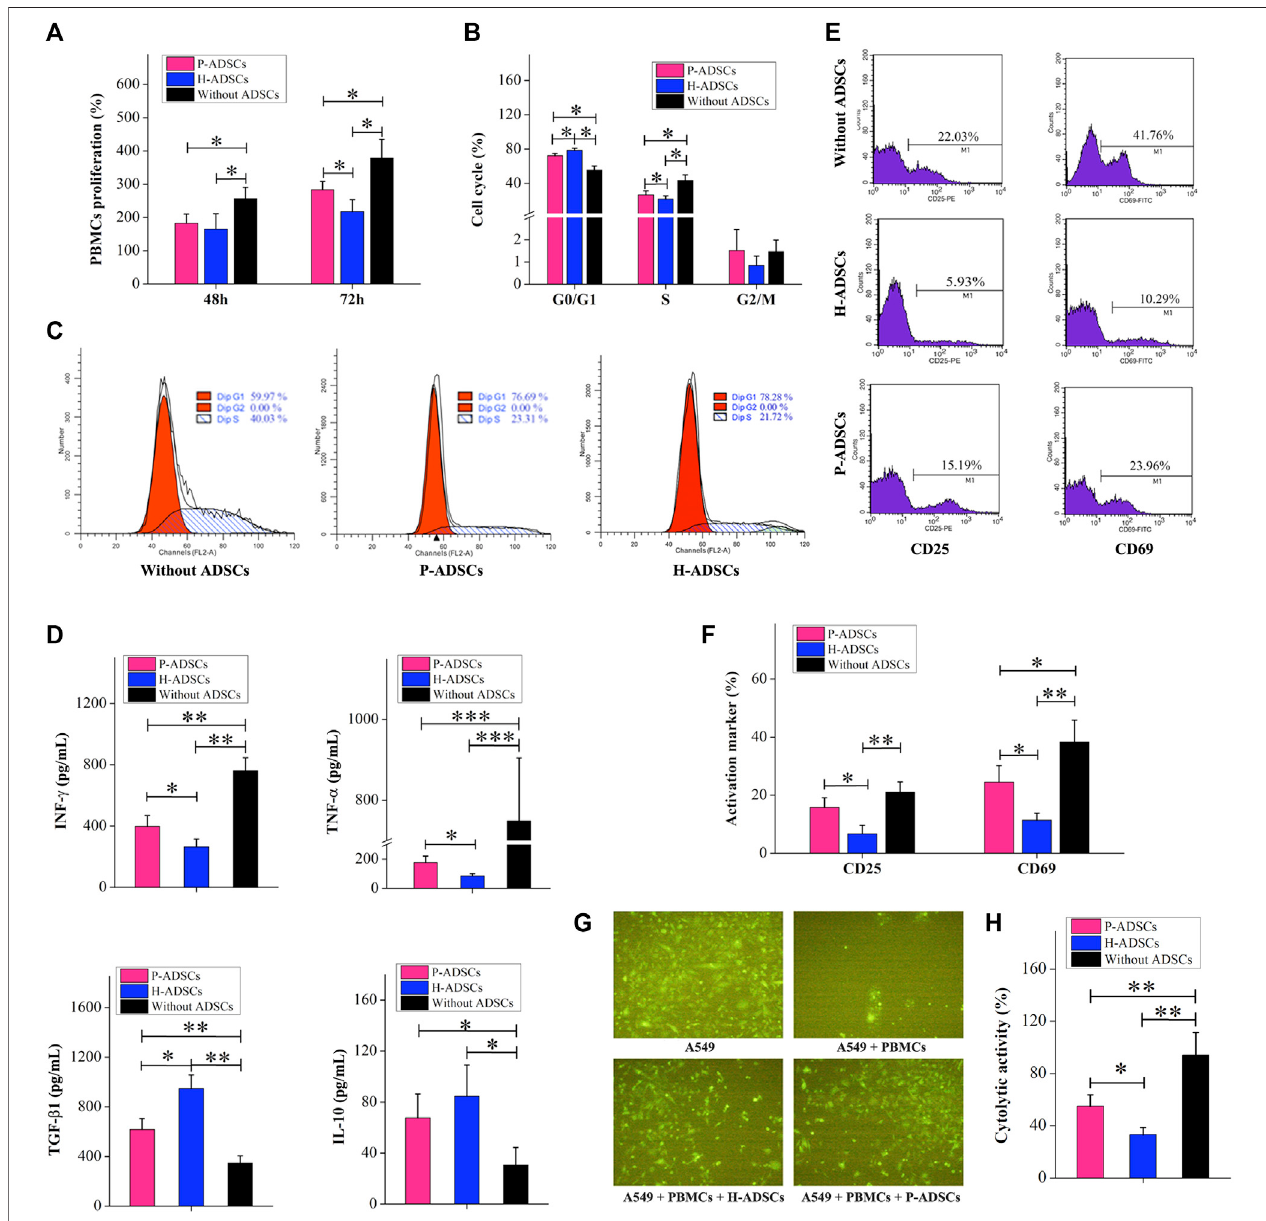
FIGURE 4 | Comparison of the immunosuppressive capacities of P-ADSCs and H-ADSCs (A) : Proliferation rate of PBMCs co-cultivated with P-ADSCs or H-ADSCs. n = 7; * p < .05 determined by the Kruskal – Wallis one-way analysis (B) : Cell cycle status of PBMCs co-cultivated with P-ADSCs or H-ADSCs. n = 7; * p < .05 determined by the Kruskal – Wallis one-way analysis (C) : Representative images of the cell cycle of PBMCs co-cultivated with P-ADSCs or H-ADSCs (D) : Expression levels of the in fl ammatory factors IFN- γ , TNF- α , TGF- β l, and IL-10 of PBMCs co-cultivated with P-ADSCs or H-ADSCs. n = 7; * p < .05, ** p < .01, and *** p < .001 determined by the Kruskal – Wallis one-way analysis (E) : Representative histograms of activated markers CD25 and CD69 of PBMCs co-cultivated with P-ADSCs or H-ADSCs (F) : Expression level of CD25 and CD69 of PBMCs co-cultivated with P-ADSCs or H-ADSCs. n = 7; * p < .05 and ** p < .01 determined by the Kruskal – Wallis one-way analysis (G) : Representative immuno fl uorescence images of A549 co-cultivated with PBMCs/P-ADSCs or H-ADSCs. (100×) (H) : Cytotoxicity of PBMCs on A549 co-cultivated with P-ADSCs or H-ADSCs. n = 7; * p < .05 and ** p < 0.01 determined by the Kruskal – Wallis one-way analysis.